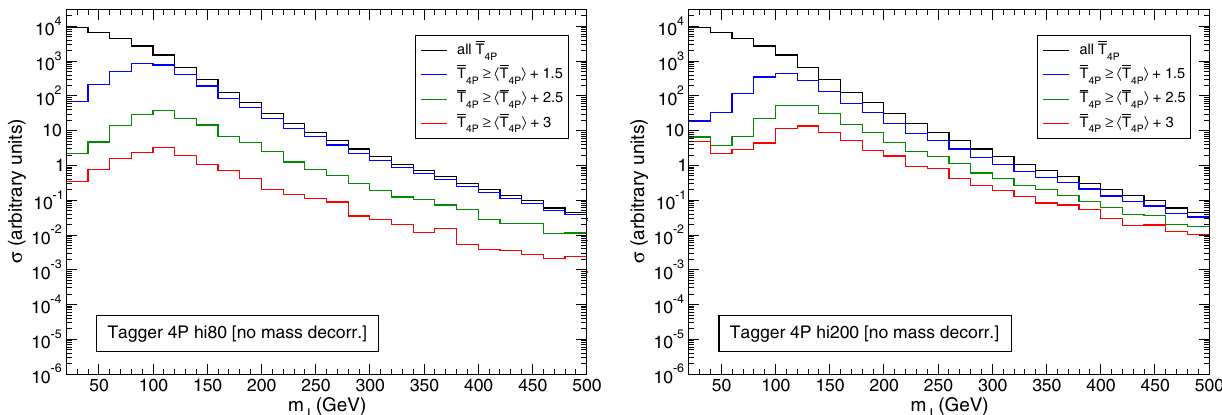
Fig. 9 Jet mass distribution of the QCD background after increasingly tighter cuts on the ¯ T 4P taggers (without mass decorrelation) designed on two different jet mass intervals